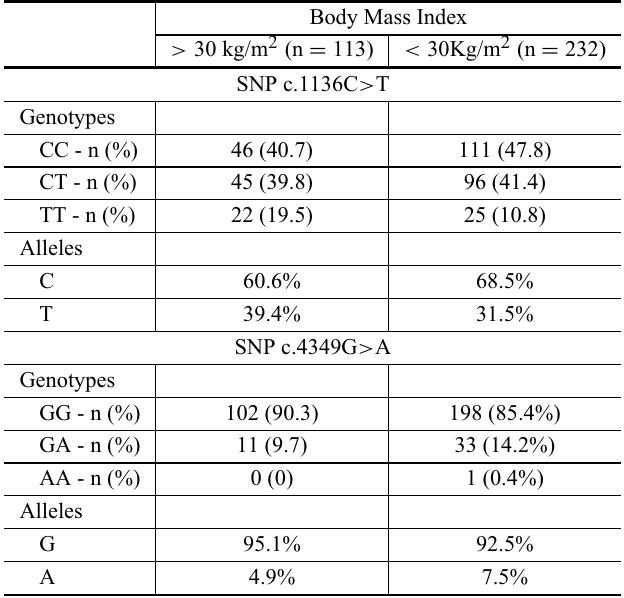
Genotypic and allelic distribution for SNP c.1136C > T and SNP c.4349G > A according to body mass